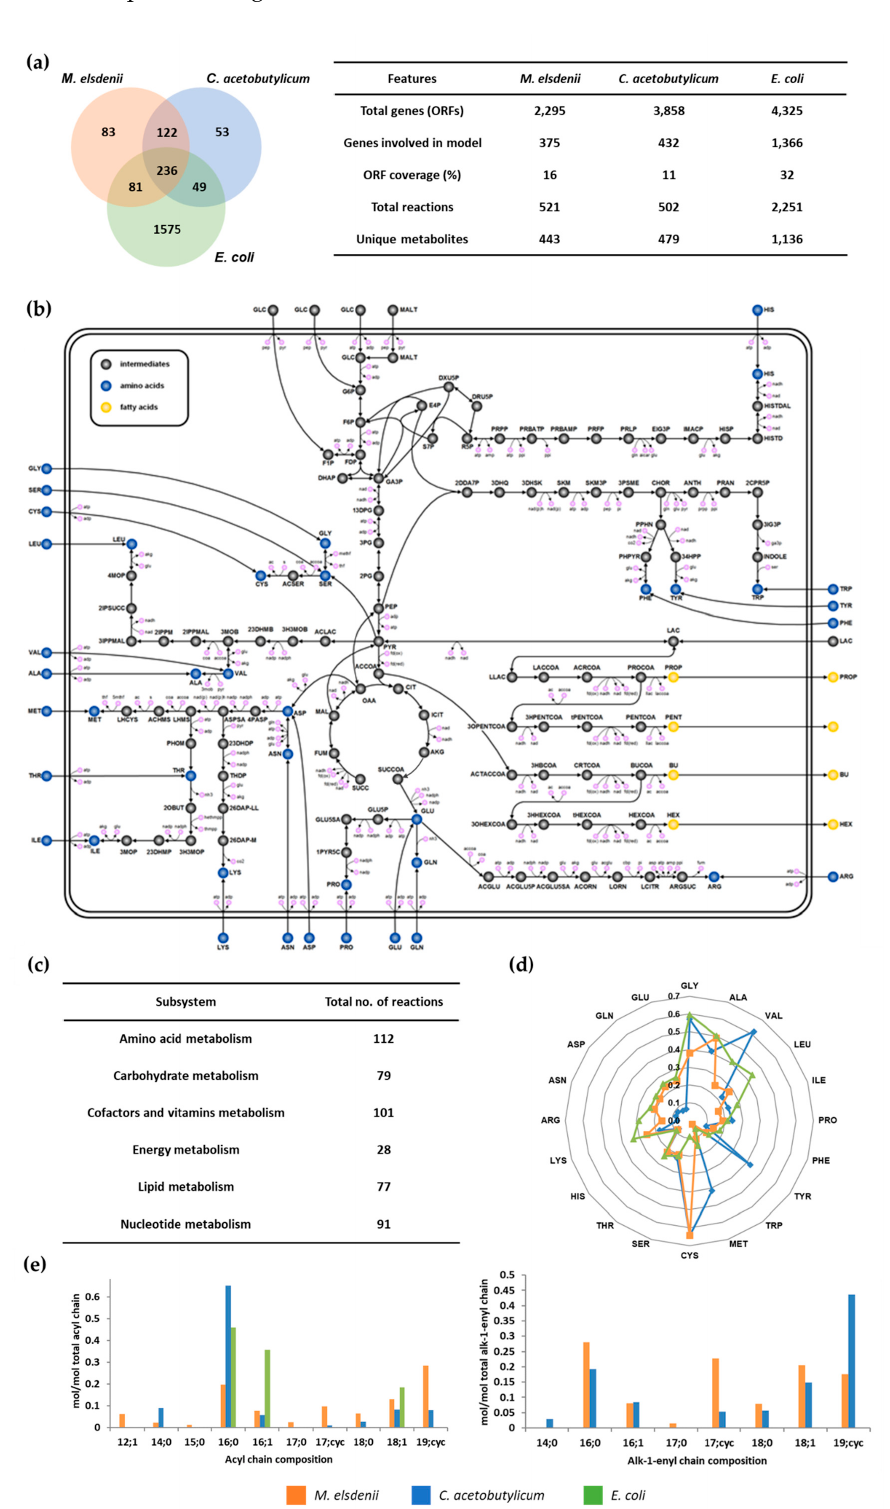
Figure 1. Comparison of metabolic network models and biomass compositions. ( a ) The metabolic reactions of i ME375 are compared with C. acetobutylicum Cac MBEL489 and E. coli i JO1366. The